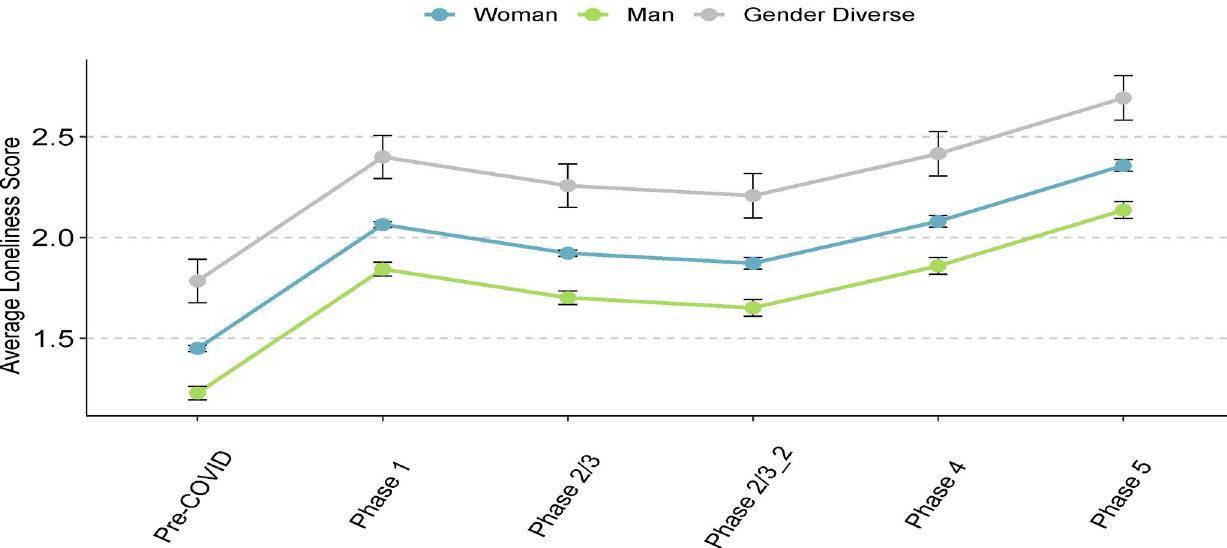
Fig 5. Loneliness symptoms across phases of the pandemic. Data points refer to mean scores of the given psychosocial measure, error bars refer to the standard error. Pre-COVID: Prior to mid-March 2020; Phase 1: Mid-March 2020 to mid-May 2020; Phase: 2/3: Mid-May 2020 to November 2020; Phase 2/